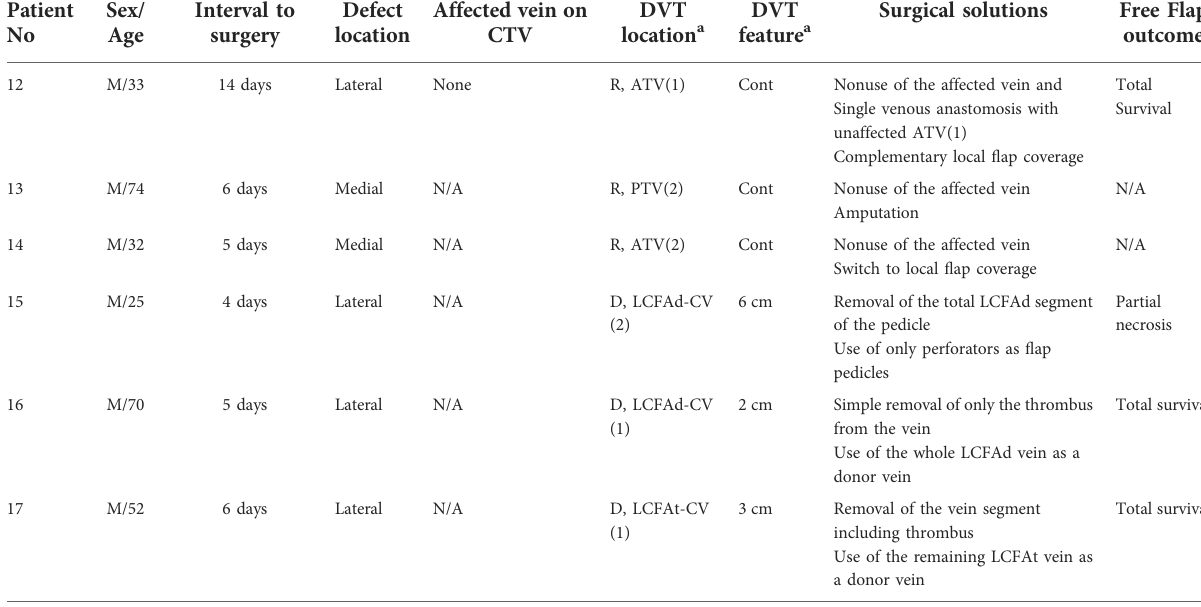
TABLE 2 Clinical features of the patients with DVT encountered intraoperatively during free ALTP fl ap transfer. Patient